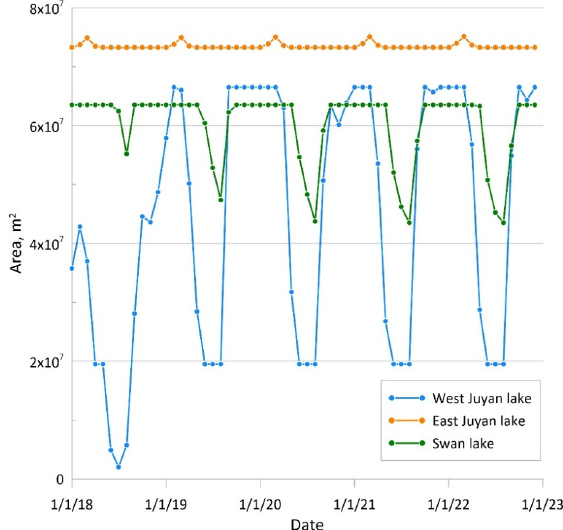
Figure 16. Predictive simulations of the terminal lake area changes for the period 2018–2022.